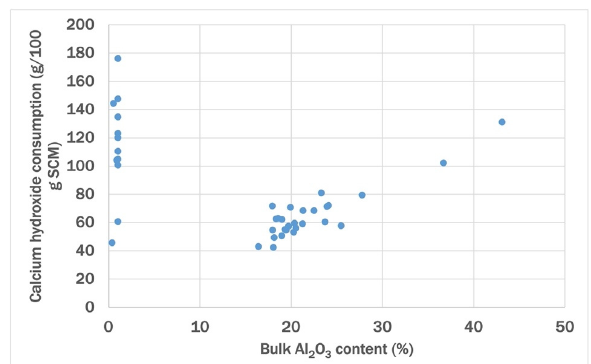
Figure 4. Calcium hydroxide consumption using the modified R 3 test plotted against bulk Al 2 O 3 content for several SCMs of different types (using data from